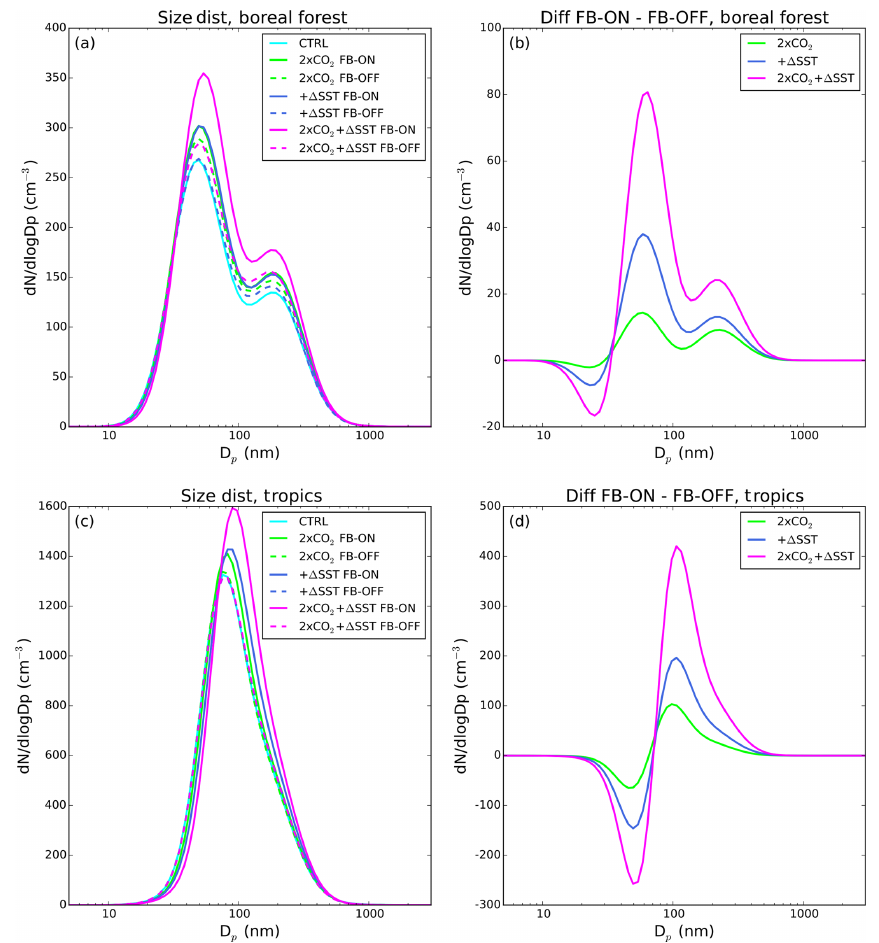
Figure 5. Annually averaged aerosol number size distributions in the boundary layer for the boreal forest region (lat.: 55 to 70 ◦ N, long.: 180 ◦ W to 180 ◦ E) and the region around the tropical islands in southeast Asia (lat.: 20 ◦ S to 20 ◦ N, long.: 90–130 ◦ E). In panels (a) and (c) , the distributions from the CTRL and the three experiments are plotted, while in panels (b) and (d) , the differences between the FB-ON and FB-OFF simulations are